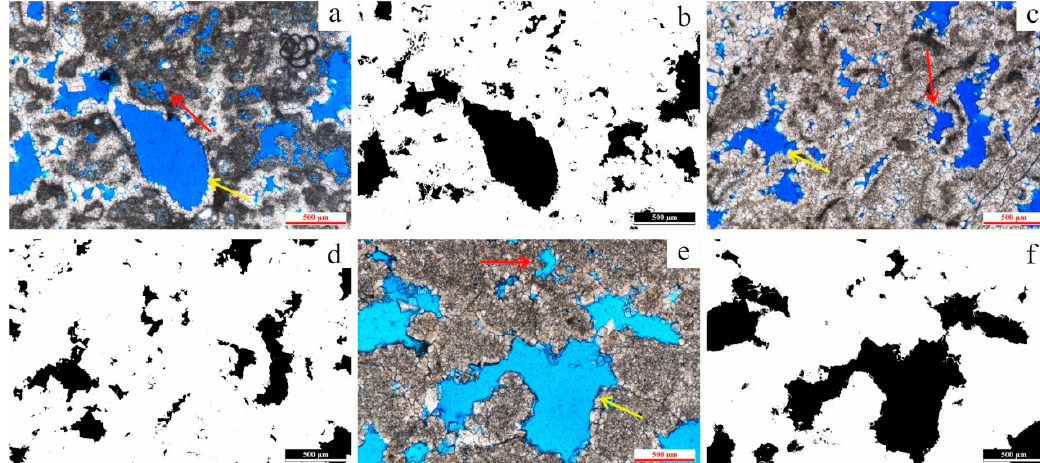
Figure 7. Comparison of the original image of thin sections generated by the Image-J software. ( a ) Inter-clot pores (yellow arrow) and intra-clot pores (red arrow) in thrombolites, T 2 l 43 , Yangshen-1 well, 6228.60 m; ( b ) Comparison image with a: The black area represents the pores, and the white area stands for the matrix; ( c ) Inter-clot pores (yellow arrow) and intra-clot pores (red arrow) in thrombolites, T 2 l 43 , Yangshen-1 well, 6222.30 m; ( d ) Comparison image with c: The black area represents the pores, and the white area stands for the matrix; ( e ) Inter-clot pores (yellow arrow) and intra-clot pores (red arrow) in thrombolites, T 2 l 43 , Yangshen-1 well, 6219.50 m; ( f ) Comparison image with e: The black area represents the pores, and the white area stands for the matrix.